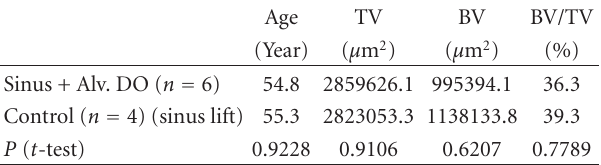
Table 3: The bone histomorphometric results for new bone formation and maturation were compared between the study group with alveolar distraction and simultaneous sinus lifting with bone grafting and a control group with sinus lifting only with the same bone graft at the time of implant placement in the simulated first molar area. Student’s t -test was used to compare bone regeneration and new bone formation between the study group ( n = 6) and control group ( n = 4). Statistical significance was defined as P < 0 .